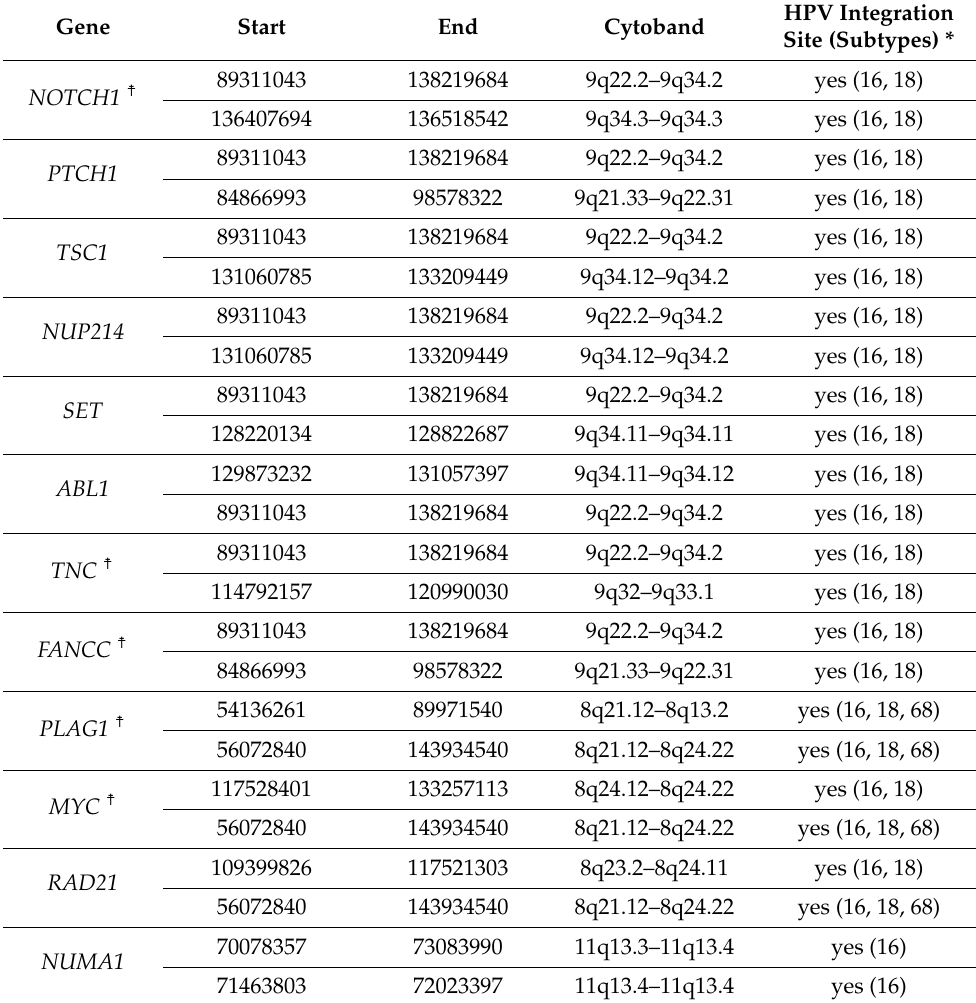
Table 3. Cancer-related genes with gain ( ≥ 3 copies) detected in 10% of human-papillomavirus-associated penile squamous cell carcinomas from Latin American patients. The specified cytobands have over 10 Kb.